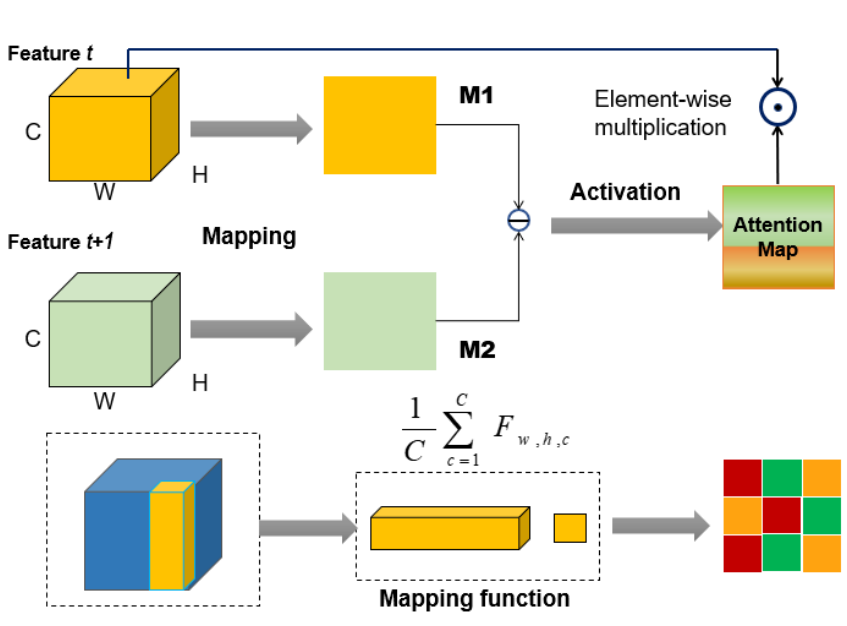
Figure 4. The process of